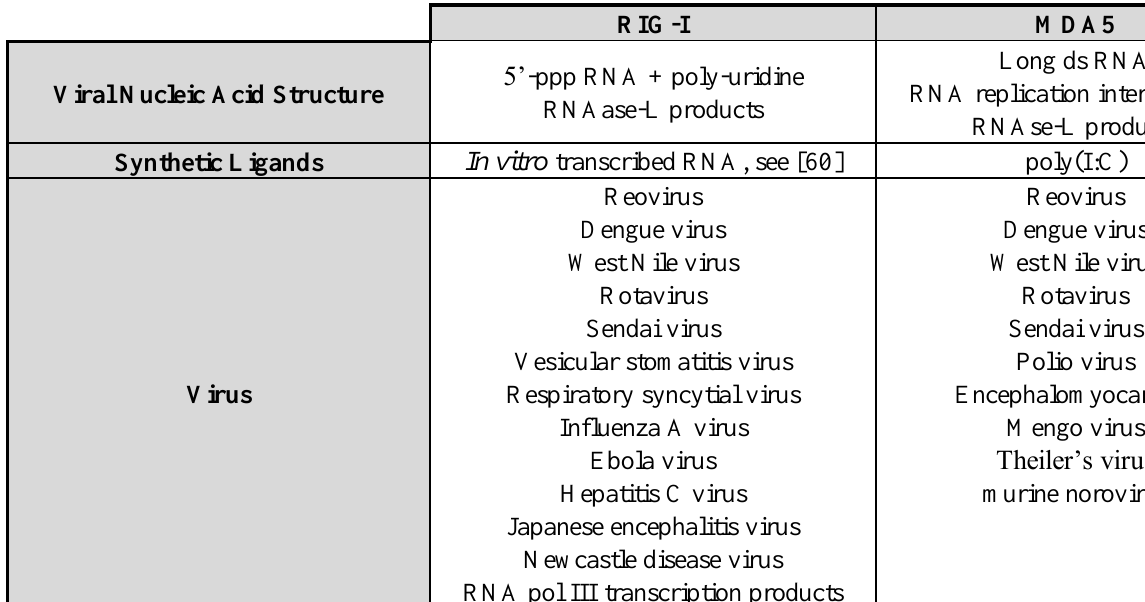
Table 1. RIG-I-like receptors (RLRs)